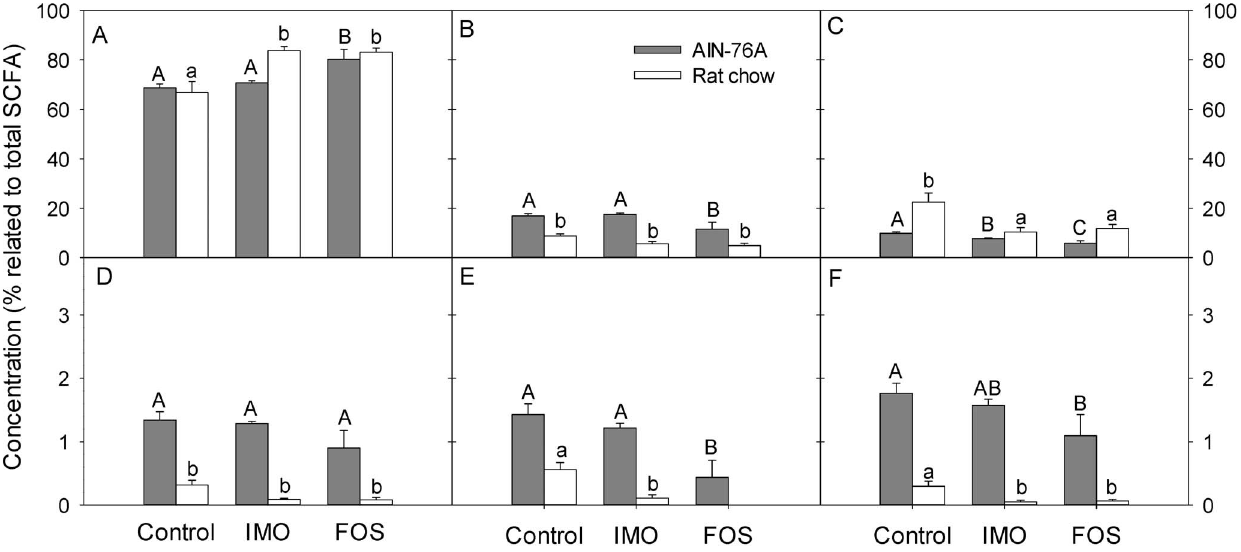
Figure 4. Effects of diets and fibre additives on SCFA concentration in cecal contents. Samples were collected at the end point of the fibre treatment of HLA-B27 transgenic rats. Vertical bars show concentration of the respective SCFA related to the concentration of total SCFA and values are expressed as means 6 SEM, n=6 and n=8 for rat chow and AIN-76A diet, respectively. Values that do not share a common superscript differ significantly ( P , 0.05, Bonferroni adjustment). A – acetate; B – propionate; C – butyrate; D – isobutyrate; E – valerate; F – isovalerate. Total SCFA concentrations were 220 6 23, 239 6 11 and 183 6 17 m mol/g for control, IMO, and FOS groups, respectively in digesta from treatment groups on rat chow and 118 6 11, 195 6 17 and 132 6 10 m mol/g for control, IMO, and FOS groups, respectively, in digesta from treatment groups on AIN-76.